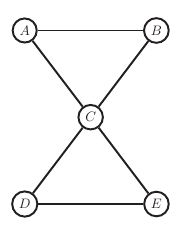
Figure 8. A graph on which we find the treewidth.